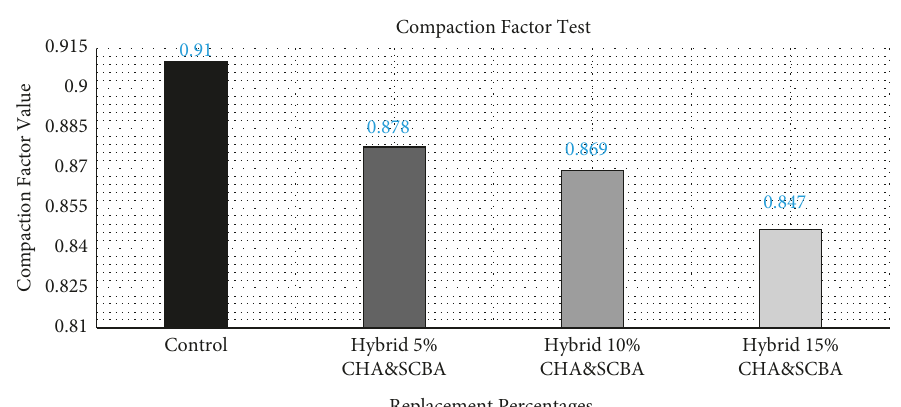
Figure 6: Slump test result.